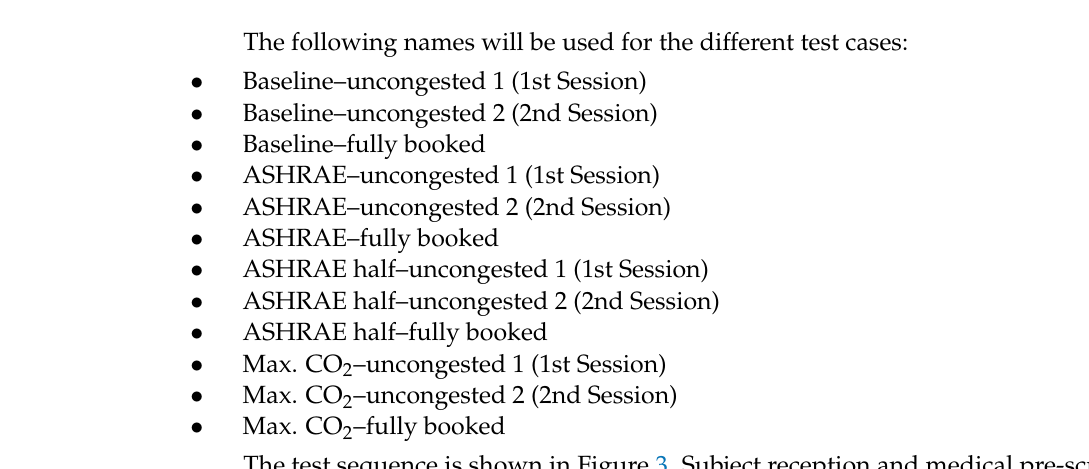
Figure 4. Example of Cabin pressure profile 2.3. Assessment of Air Quality The assessment of the indoor environment was performed by a trained sensory panel according to the requirements of ISO 16000-30 [17] and subjects’ ratings via questionnaire at the end of the session. For the first test of each condition, a sensory panel consisting of eight trained test persons entered the cabin and assessed the perceived intensity, the hedonic odor tone and the odor quality of the cabin air. Their evaluation of perceived intensity (pi) uses of a com- parative scale, that assigns the odor intensity of air to a defined concentration of acetone (Figure 5). Hedonic odor tone is assessed on a 9 point category scale from − 4 (very un- pleasant), via 0 (neither pleasant nor unpleasant) to +4 (very pleasant).